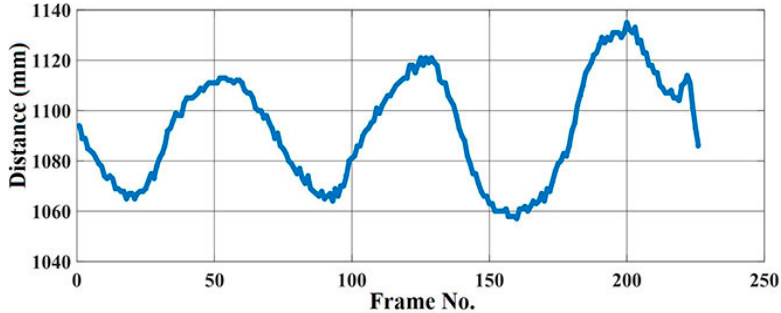
Figure 5. Depth variation over 8 s using the Kinect v2 ToF sensor (camera frequency: 30 frames per second).